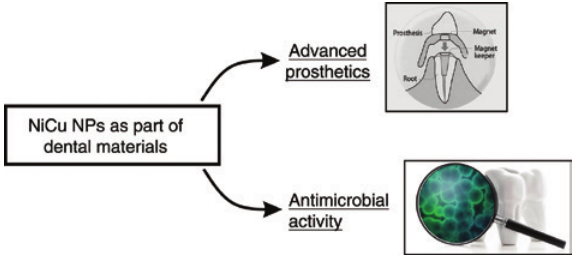
Figure 14: Possible biomedical applications of NiCu MNPs as part of dental materials. Upper right: MNPs can be used as part of pros- thetic dental materials, where they can enable advanced mechanical functions or also serve for therapeutic means (targeted delivery). Bottom right: Many different MNP (Ni, Cu, Ag, etc.) based materials have also antimicrobial